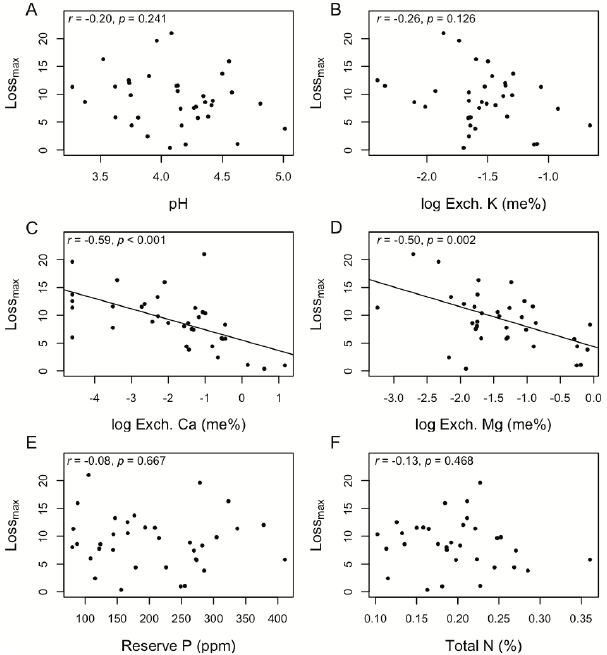
Figure 5. The relationship between the stand-level percent stem biomass lost to stem rot (Loss max ) among trees sampled in a cluster and mean soil chemical properties for 36 tree clusters containing at least 10 trees ≥ 30cm DBH. The Pearson correlation coefficient ( r ) and associated probability of each relationship is in its respective panel. Soil concentrations are expressed in units of milliequivalents per 100g of soil (me%), parts per million (ppm), or percent dry weight